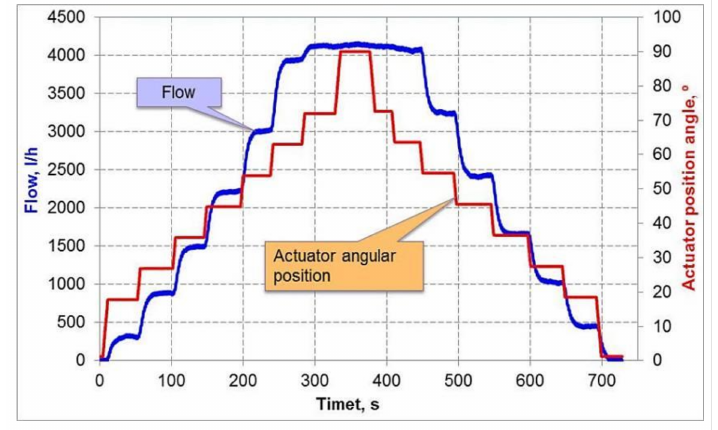
Figure 7. Tests of dynamics of flow meter readings and actuator position angle for (O/Z)Stop.